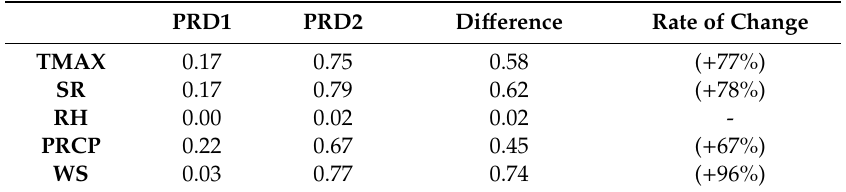
Table 3. Coe ffi cients of determination of O 3 and meteorological factors in di ff erent periods (the rate of change is presented only when the correlation coe ffi cient in Figure 5 is statistically significant in the 95% confidence interval of the Pearson’s correlation coe ffi cient. PRD1 PRD2 Di ff erence Rate of